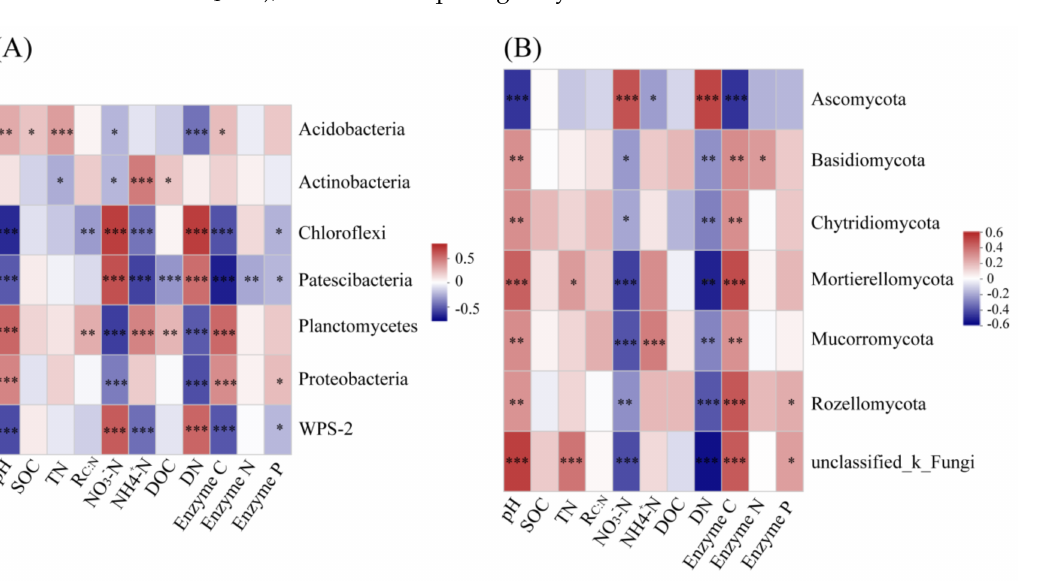
Figure 5. The heat map of the relationship between species and environmental factors at the phy- lum level of bacteria ( A ) and fungal ( B ) communities. Significance level: *, p < 0.05; **, p < 0.01; ***, p <